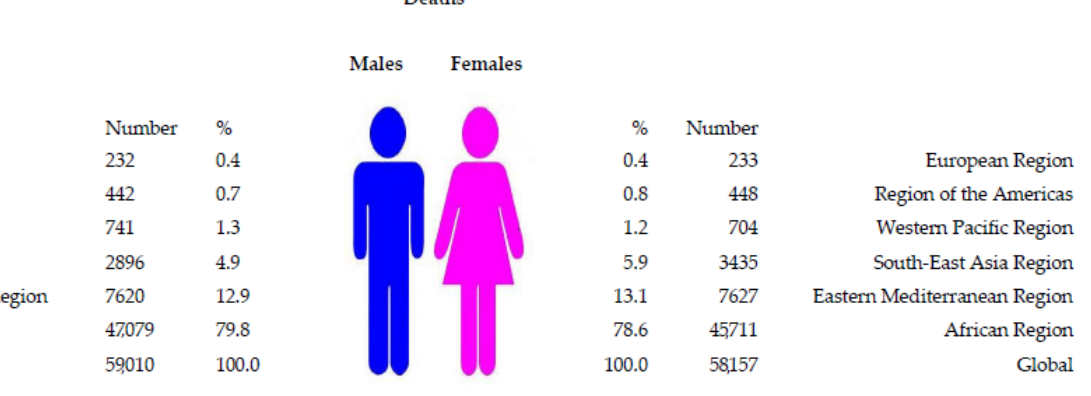
Figure 2. The number of cholera deaths, by regions of World Health Organization and sexes, 2019 (Source of data Ref. [10]).